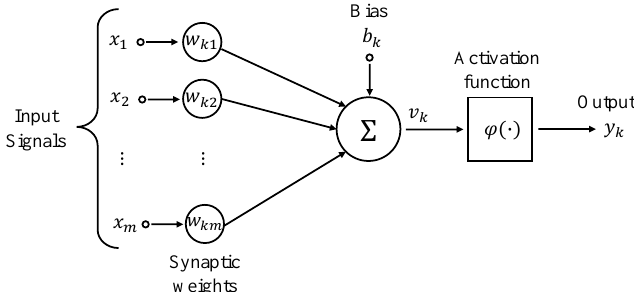
Figure 11. Scheme of an artificial